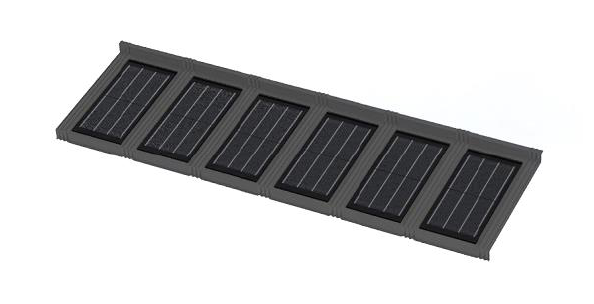
Fig. 7. Solar photovoltaic roofing proposed in the Electrotile